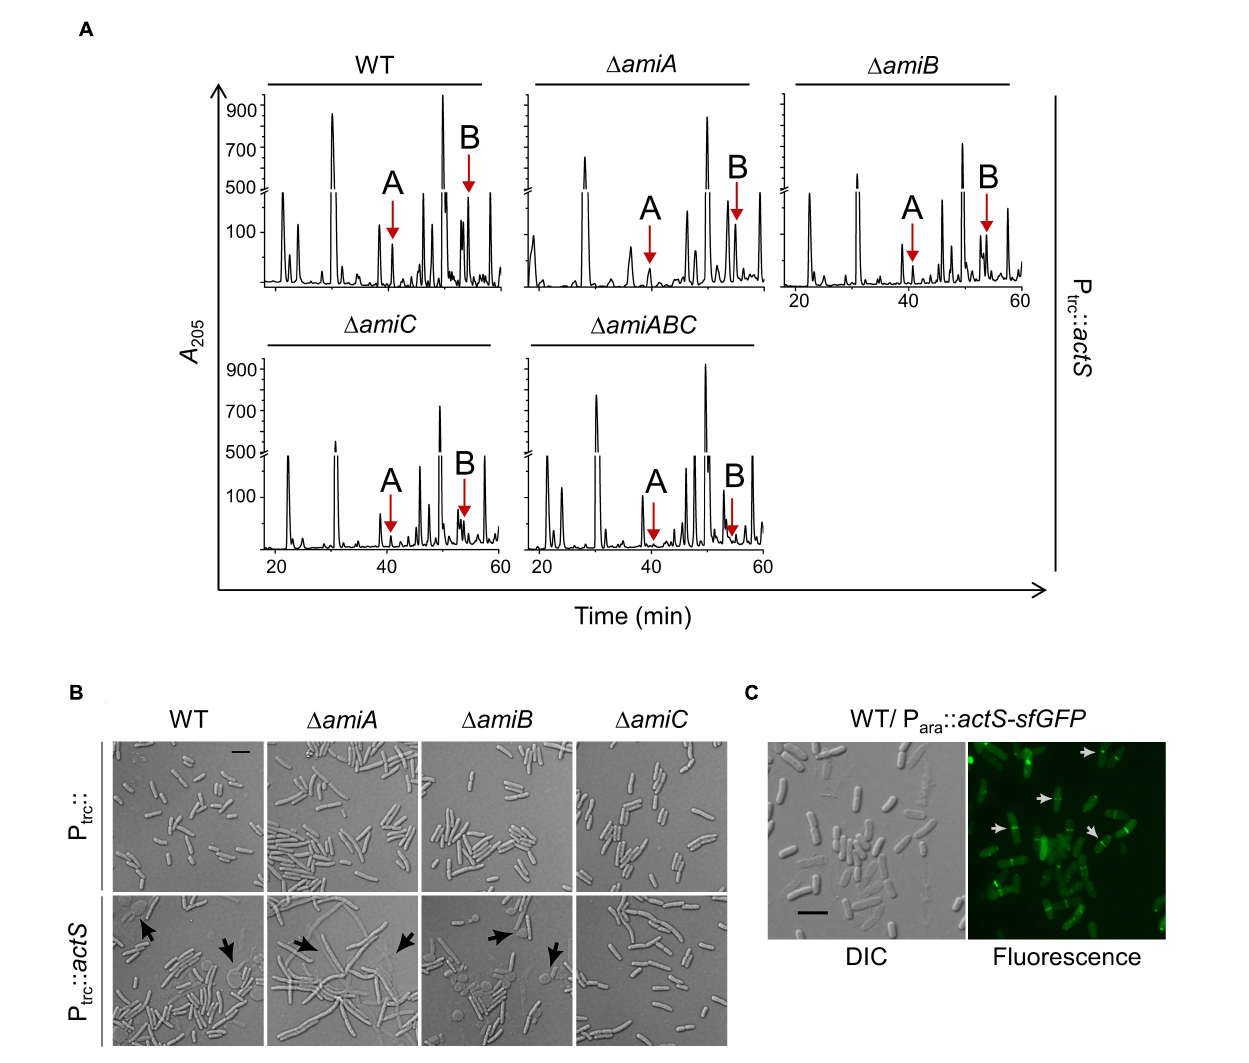
FIGURE 5 | Effect of ActS overexpression on WT and division-specific amidase mutants. (A) HPLC chromatograms depicting the PG composition of WT, (cid:49) amiA , (cid:49) amiB , (cid:49) amiC , or (cid:49) amiABC mutants with overexpressed actS (P trc :: actS ). Strains were grown to an OD 600 of ∼ 1 in LB containing 50 µ M IPTG followed by isolation and analysis of PG sacculi. (B) The strains were grown overnight and diluted 1:100 into fresh LB broth supplemented with 50 µ M IPTG and grown till OD 600 of 0.5. Cells were collected and subjected to microscopy as described the “Materials and Methods” section. Arrows indicate cell lysis, and the scale bar represents 5 µ m. (C) Localization of ActS-sfGFP was done in WT cells carrying pBAD18 actS -sfGFP. Cells were grown with 0.2% arabinose and harvested at ∼ 0.4 OD and visualized by microscopy as described in the Materials and Methods. Arrows (in white) indicate ActS localization in cells with deep constriction. The scale bar represents 5 µ m.